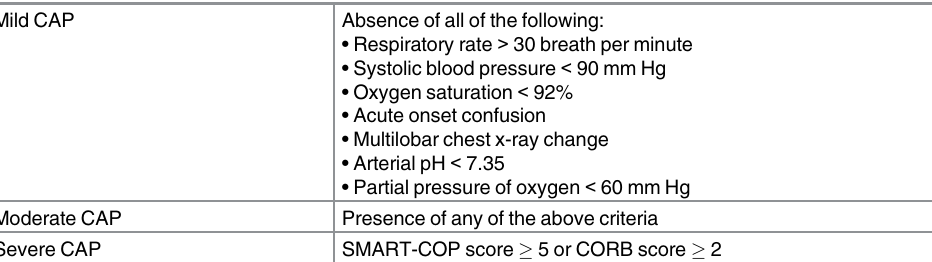
Table 1. Severity assessment of CAP based on Antibiotic Guidelines